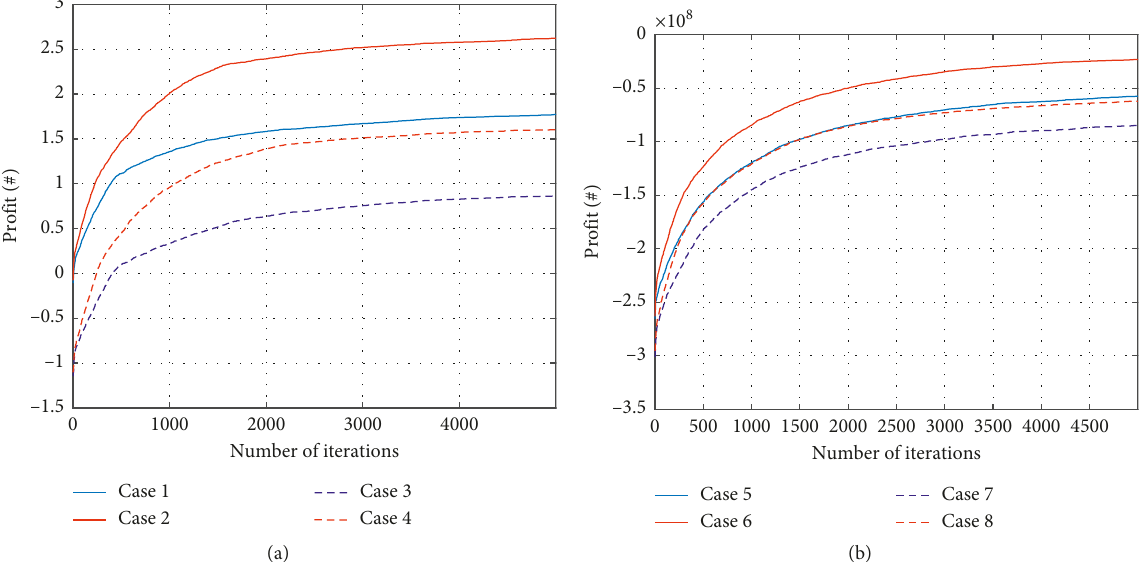
Figure 19: Profit of the community for (a) case studies 1–4 (grid tariff is Economy 7) and (b) case studies 5–8 (grid tariff is Economy